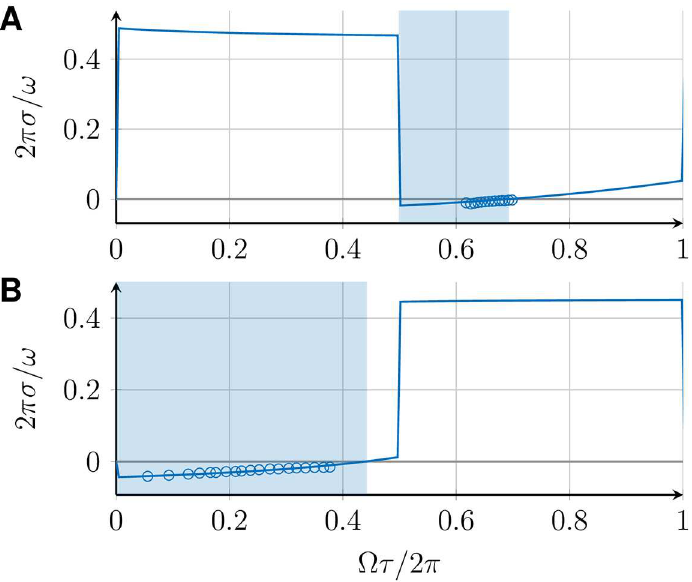
Fig 11. Experimental measurements of the perturbation response rate σ for two coupled DPLLs. Perturbation responserate σ , Eq (17), of the in-phase synchronizedstate for a system of two mutually coupledDPLLs for (A) deactivatedinverter and (B) activated inverter. Symbols show experimental data points. Lines show results of the phasemodel, solutions to Eq (16) with ζ = − 1, obtained numerically using a Levenberg- Marquardt algorithm[42, 43] with initial value λ 0 = 0.1 + i 0.1. The shadedareas displaythe stability regions of the in-phasesynchronizedstate as given by the phase model. © 2015 IEEE. Reprinted, with permission, from IEEE Proceedings: Synchronization of mutually coupleddigital PLLs in massive MIMO systems .